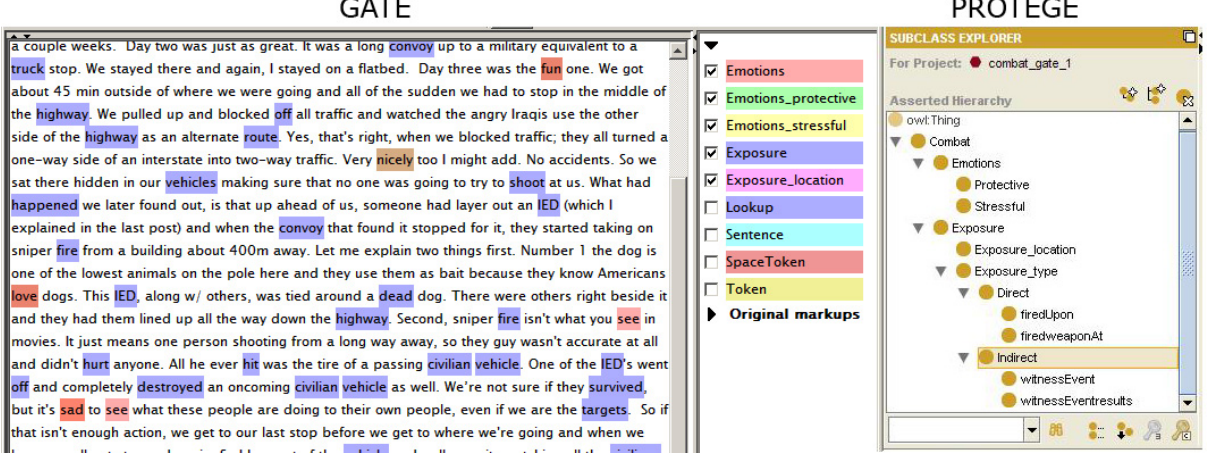
Table 2. Classification of blog text by relevancy to combat exposure by expert opinion and by our GATE pipeline for which the threshold is 4.95% Relevance of Text to Combat Exposure (Italics = Relevant, Nonitalics = Irrelevant) )According to Expert